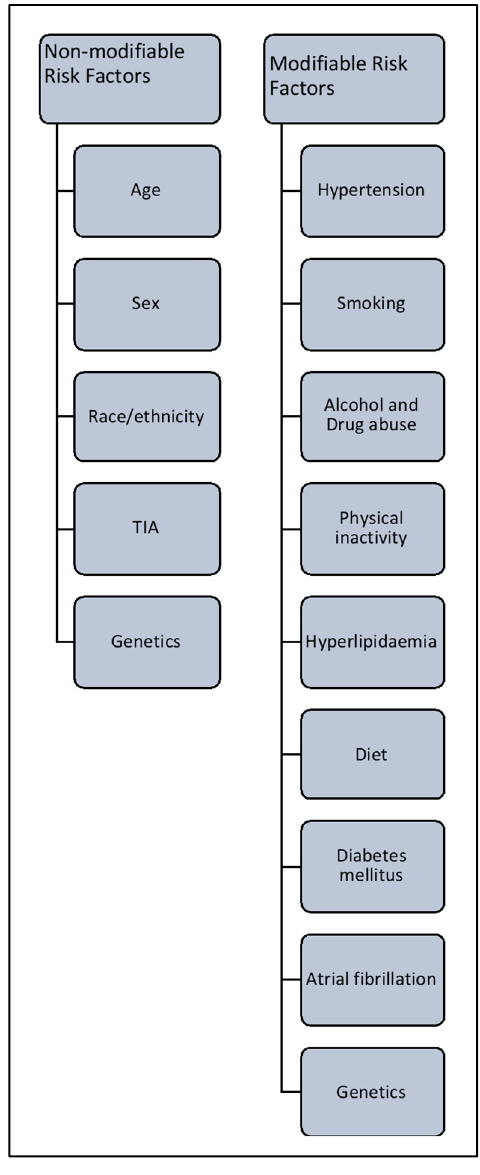
Figure 2. Risk factors associated with stroke.